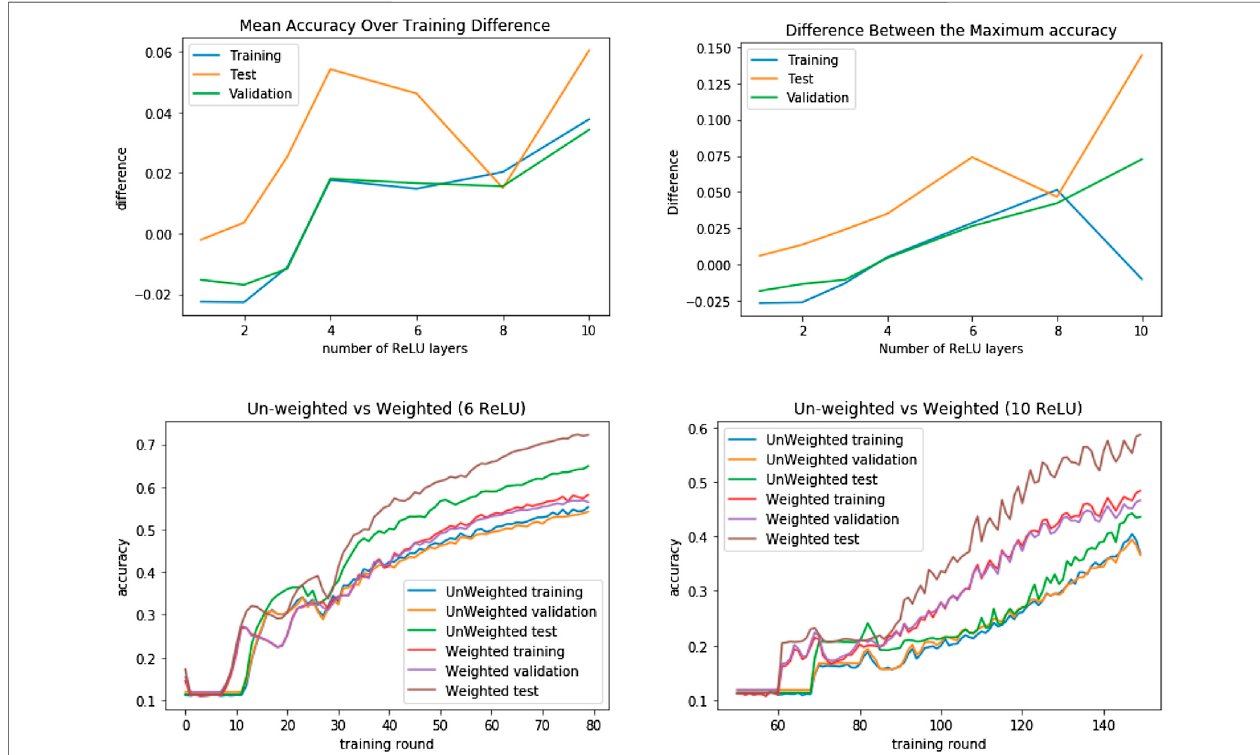
FIGURE8| The fi rsttwo(upper)plotsshowthedifferencebetweenthemeanandmaximumaccuracyobtainedthroughthetrainingofeachofthemodels.Thelast two(lower)plotsshowtheevolutionofaccuracythroughtrainingforthedatasets.Thedatasetsusedare(training,testandvalidation),withdatafromtheMNISTdataset. The (training and validation) data sets were salted with %40 of the data randomly corrupted while the test set was not. From the fi rst two plots we can see that the accuracy of the models trained with algorithmic sample weights is consistently higher than the models trained without them, and this effect increases with the variance of the models. The drops observed after 4 ReLU layers are because, until depth 10, the number of training rounds was constant, with more training rounds therefore needed to achieve a minimum in the cost function. When directly comparing the training history of the models of depth 6 and 10 we can see that the stated effect is consistent. Furthermore, at 10 rectilinear units, we can see signi fi cant over fi tting, while for the unweighted model, using the algorithmic weights still leaves room for